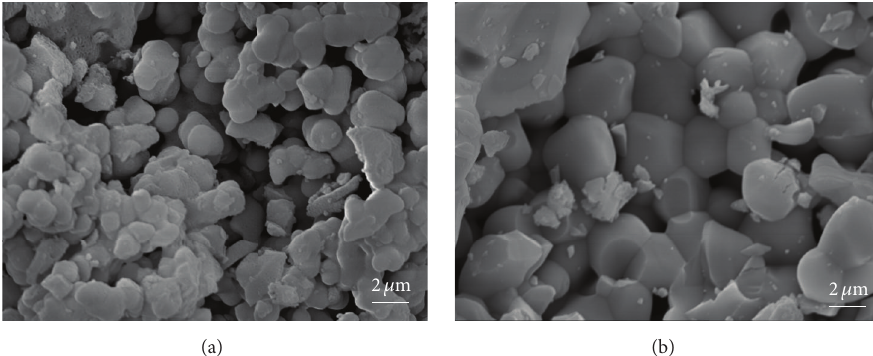
Figure 3: Surface morphology of the BZN prepared at (a) 550 ∘ C by the sol-gel and (b) 1000 ∘ C by the solid-state methods.